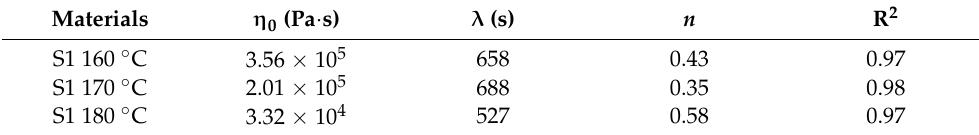
Table 2. Fitting parameters of the Carreau model for S1 under various